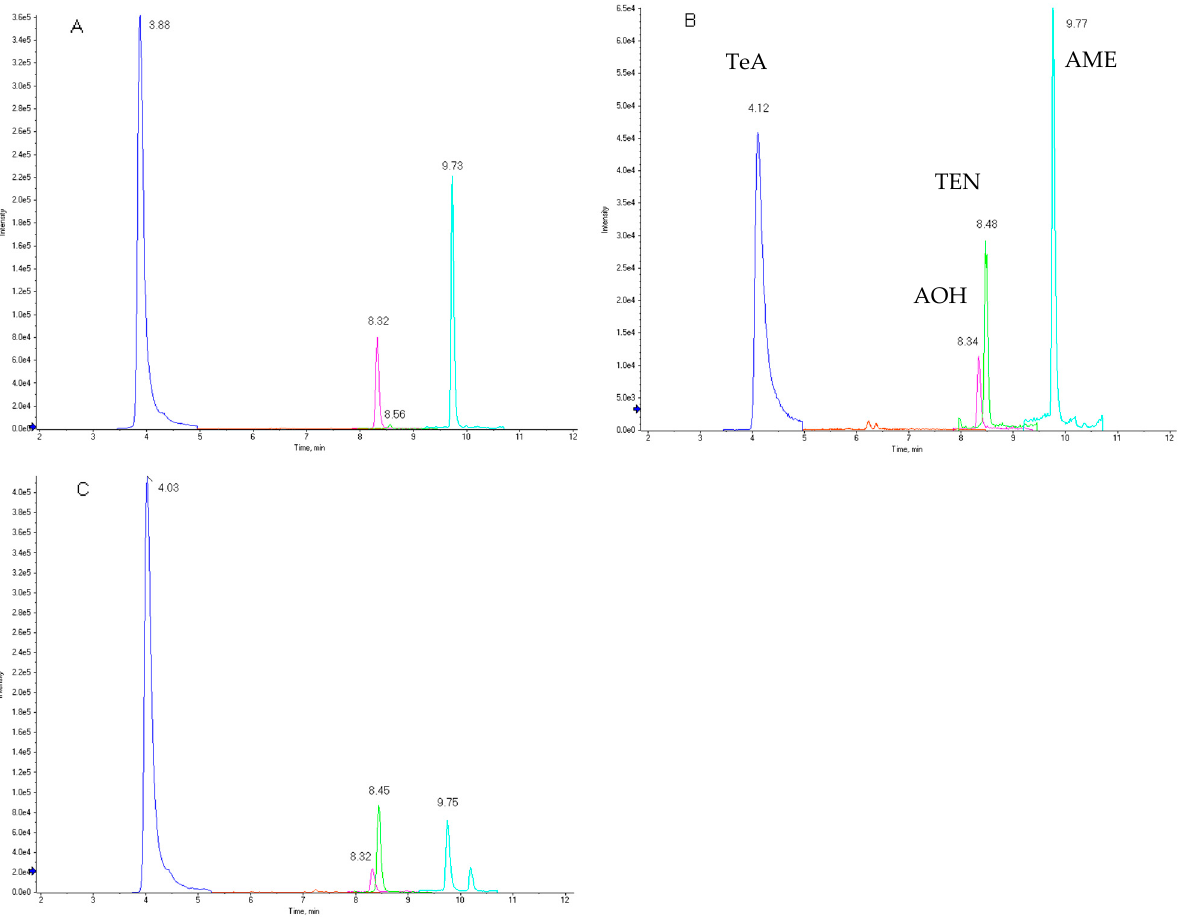
Figure 3. Representative chromatograms of the analysis of ATs in food samples. ( A ) Tomato puree: TeA 530 µg/kg, AOH 13.2 µg/kg, TEN 0.6 µg/kg (insert) and AME 5.7 µg/kg. ( B ) Wheat flour: TeA 160 µg/kg, AOH 1.7 µg/kg, TEN 5.7 µg/kg and AME 1.2 µg/kg. ( C ) Sunflower seeds: TeA 550 µg/kg, AOH 5.6 µg/kg, TEN 18.9 µg/kg and AME 4.1 µg/kg.